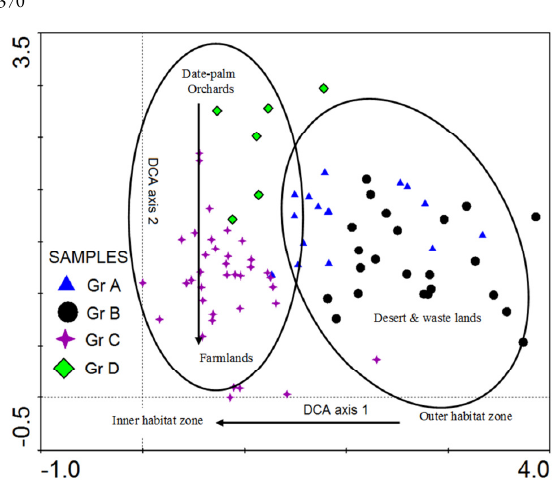
Fig. 4. Canonical correspondence analysis (CCA) biplot along axes 1 and 2, showing the distribution of the 84 stands and their correlations with the environmental variables and vegetation groups